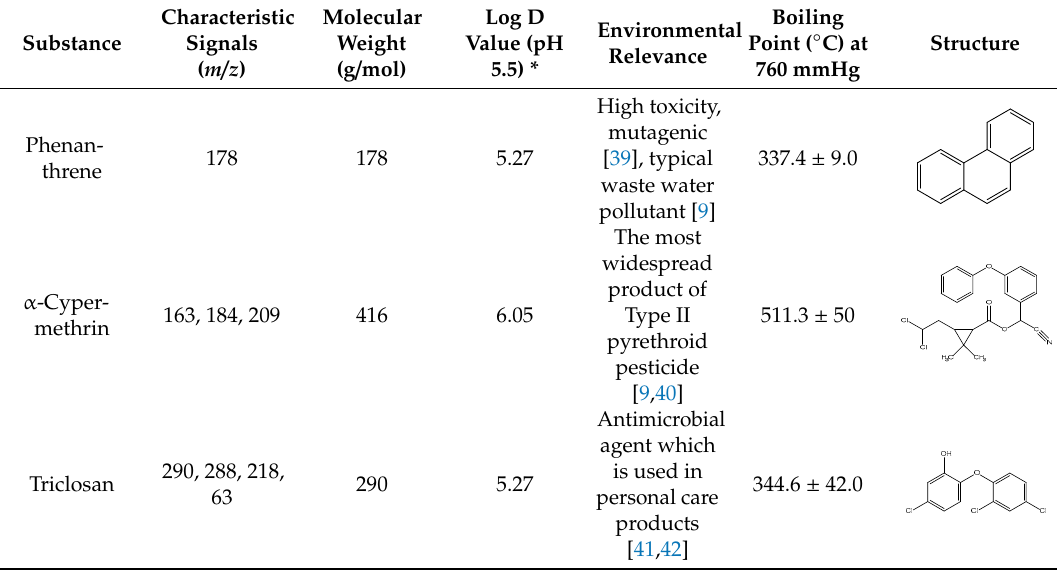
Table 2. Characteristic signals, properties and structure of chosen substances.